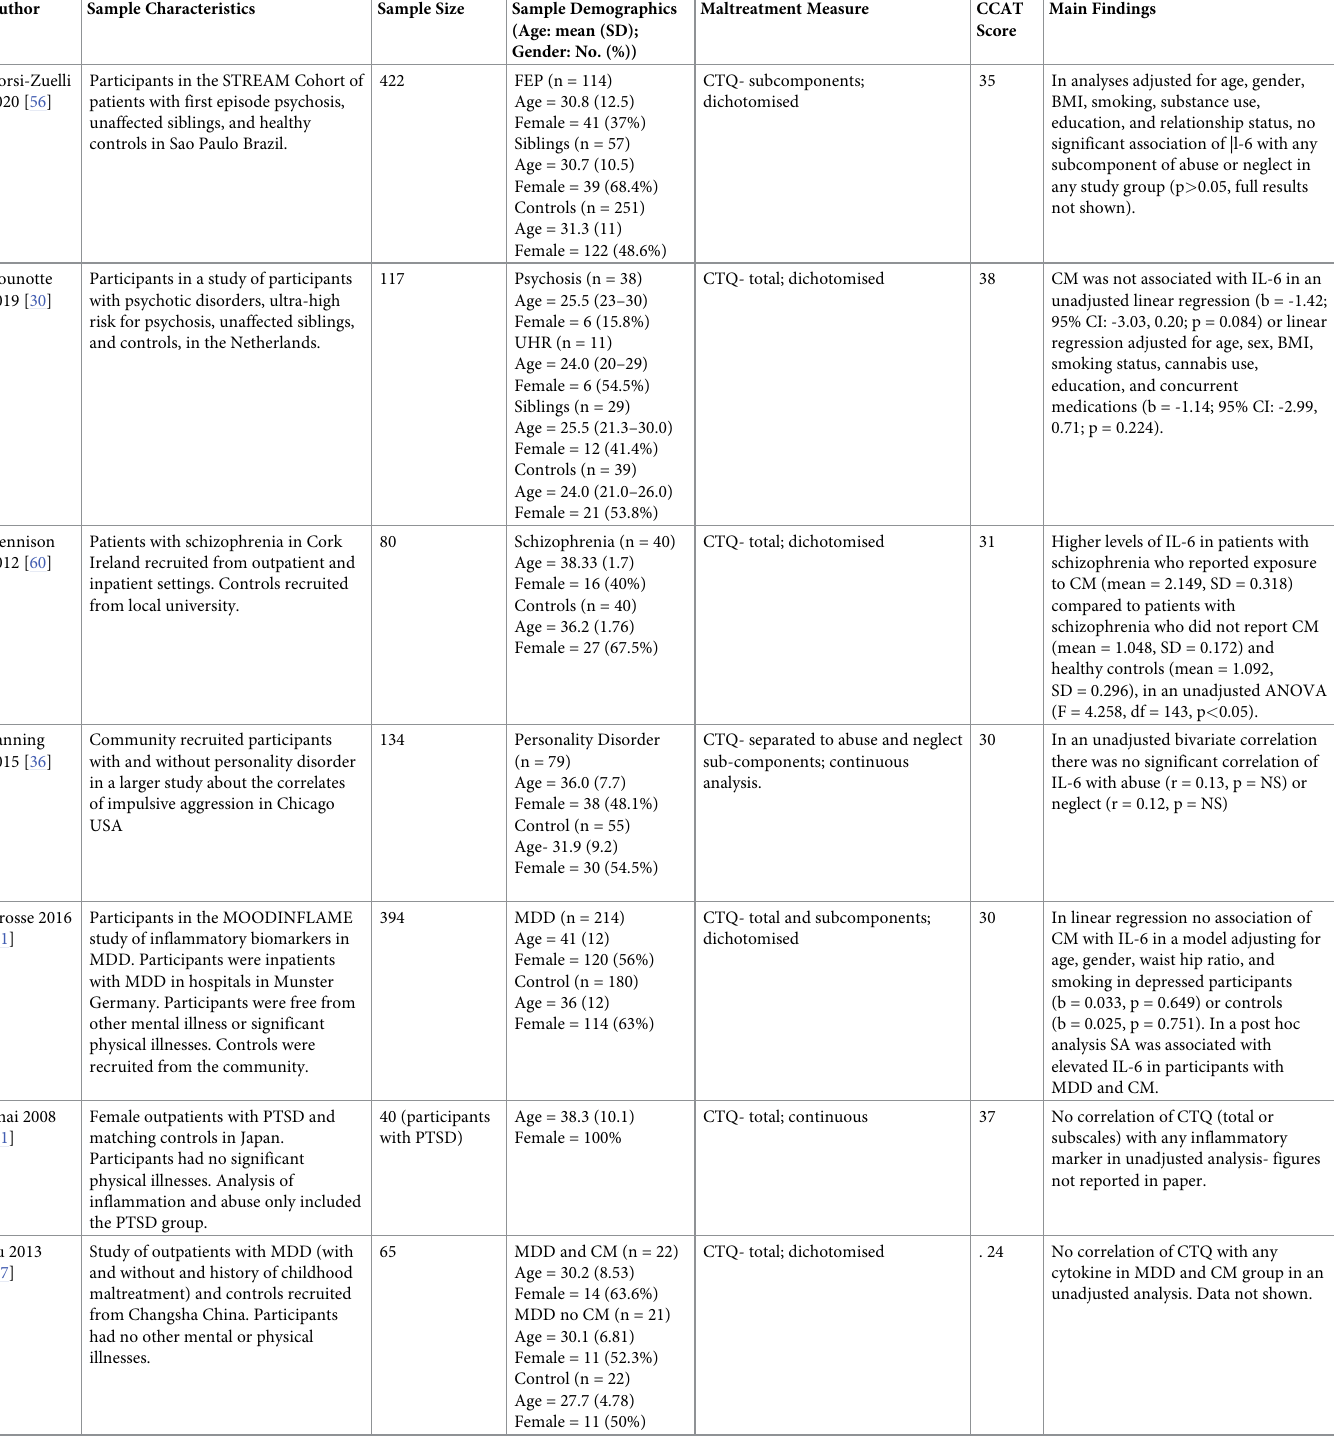
Table 3. a. Studies reporting interleukin-6: Clinical populations. b Samples reporting interleukin-6: Non-clinical